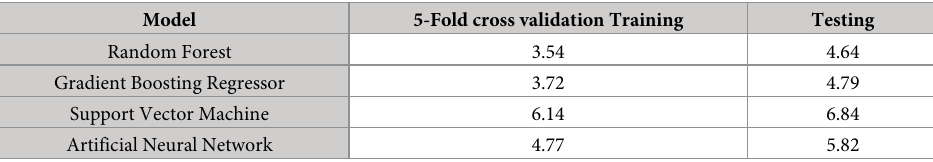
Table 6. Performance of the ML models in terms of Mean Absolute Error